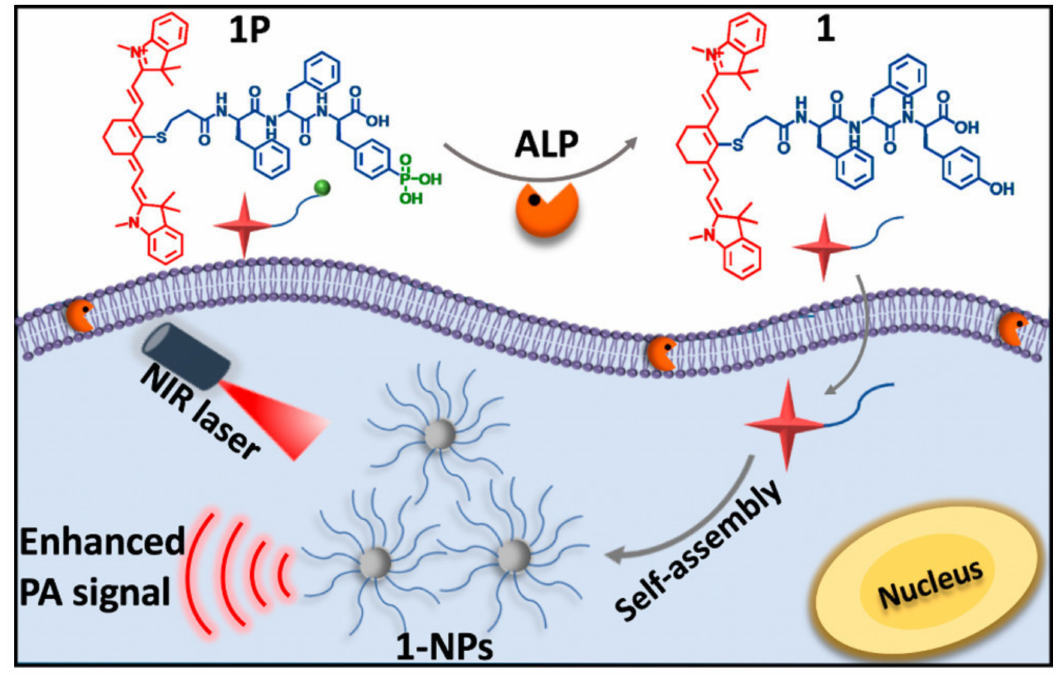
Figure 4. ALP-triggered self-assembly of near-infrared nanoparticles for the enhanced PA imaging of tumors. Adapted from ref [29], with permission from Copyright © 2018, American Chemical